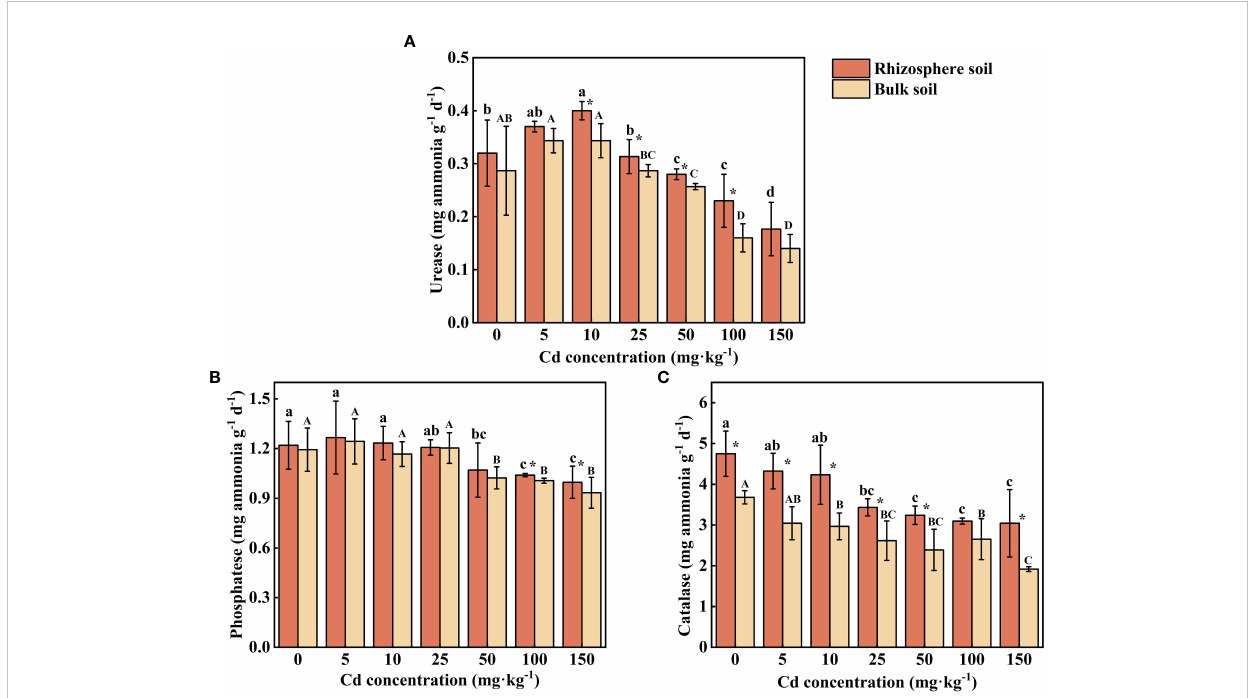
FIGURE 6 Effects of Cd on activity of urease (A) , phosphatase (B) and catalase (C) in the rhizosphere soil and bulk soil of S. orientalis . Error bar represents standard deviation (n=3). * indicate signi fi cant difference at P < 0.05 level in the same treatment between rhizosphere and bulk soil, different lower case letter (upper case letter) at the column indicate signi fi cant difference at P < 0.05 level in the rhizosphere soil (in the bulk soil) according to ANOVA and Duncan tests, the same as